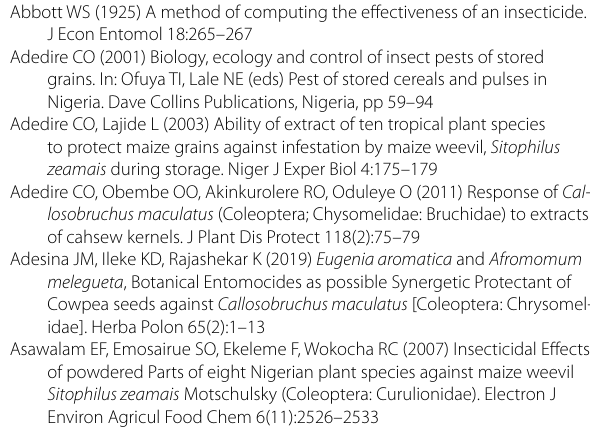
Abbreviations FUTA : Federal University of Technology, Akure; ANOVA: Analysis of variance; SE: Standard error; LD: Lethal dose; LC: Lethal concentration; BPI: Beetle Perfora-